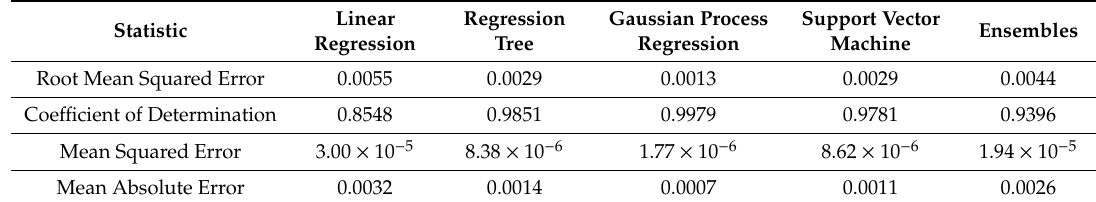
Table 8. Evaluation of the performance of five regression models used to predict the value of the dissolved hydrogen content in the liquid